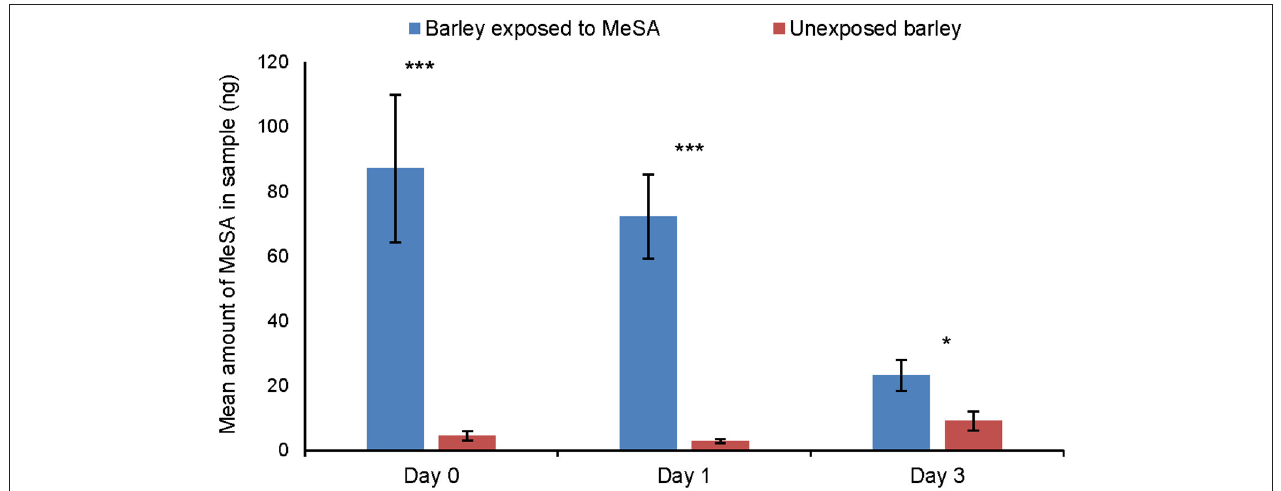
FIGURE 3 | Amount of MeSA (mean ng ± SE) quantified in the headspace of unexposed barley plants or on plants exposed to MeSA (directly after removal of MeSA exposure = Day 0 and at time points 1 and 3 days after removal of MeSA exposure). * p ≤ 0.05; *** p ≤ 0.001, after Tukey